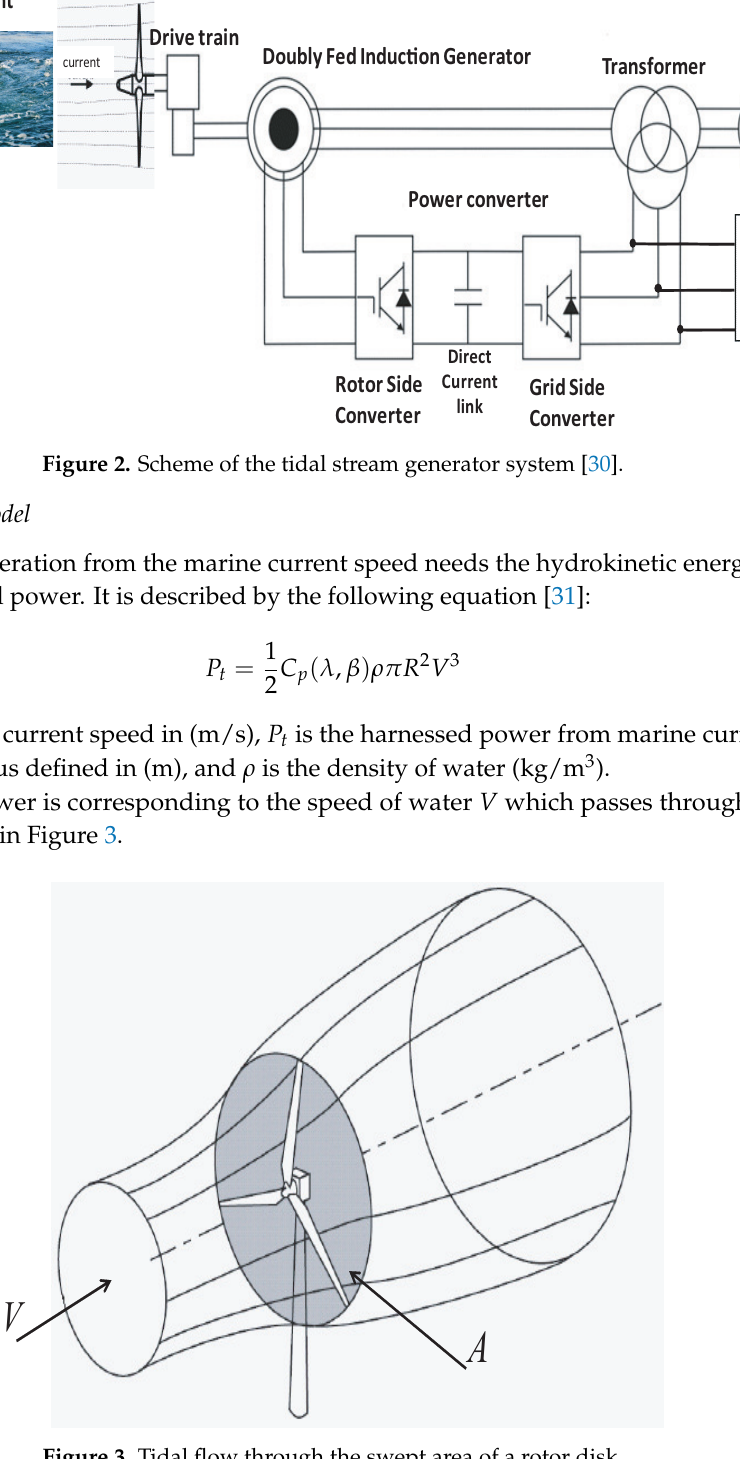
Figure 3. Tidal flow through the swept area of a rotor